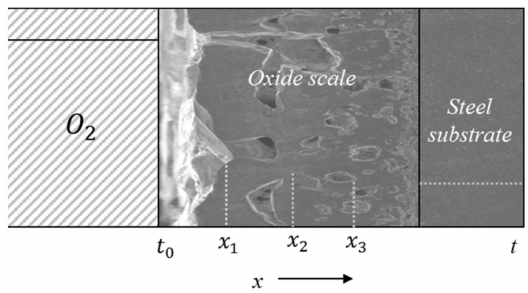
Figure 15. Prototype used for the di ff usion coe ffi cient